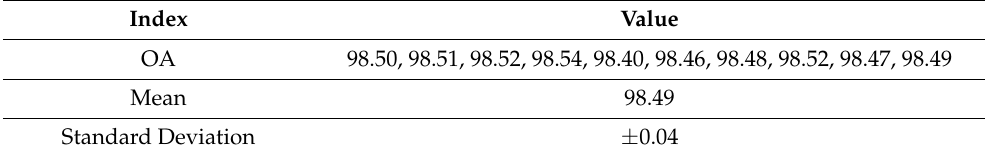
Table 7. The accuracy of the proposed method through different iterations (OA: overall accuracy).